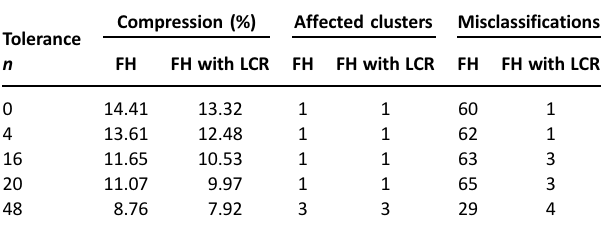
Table 1. FASTA Herder on the Orthobench. Tolerance